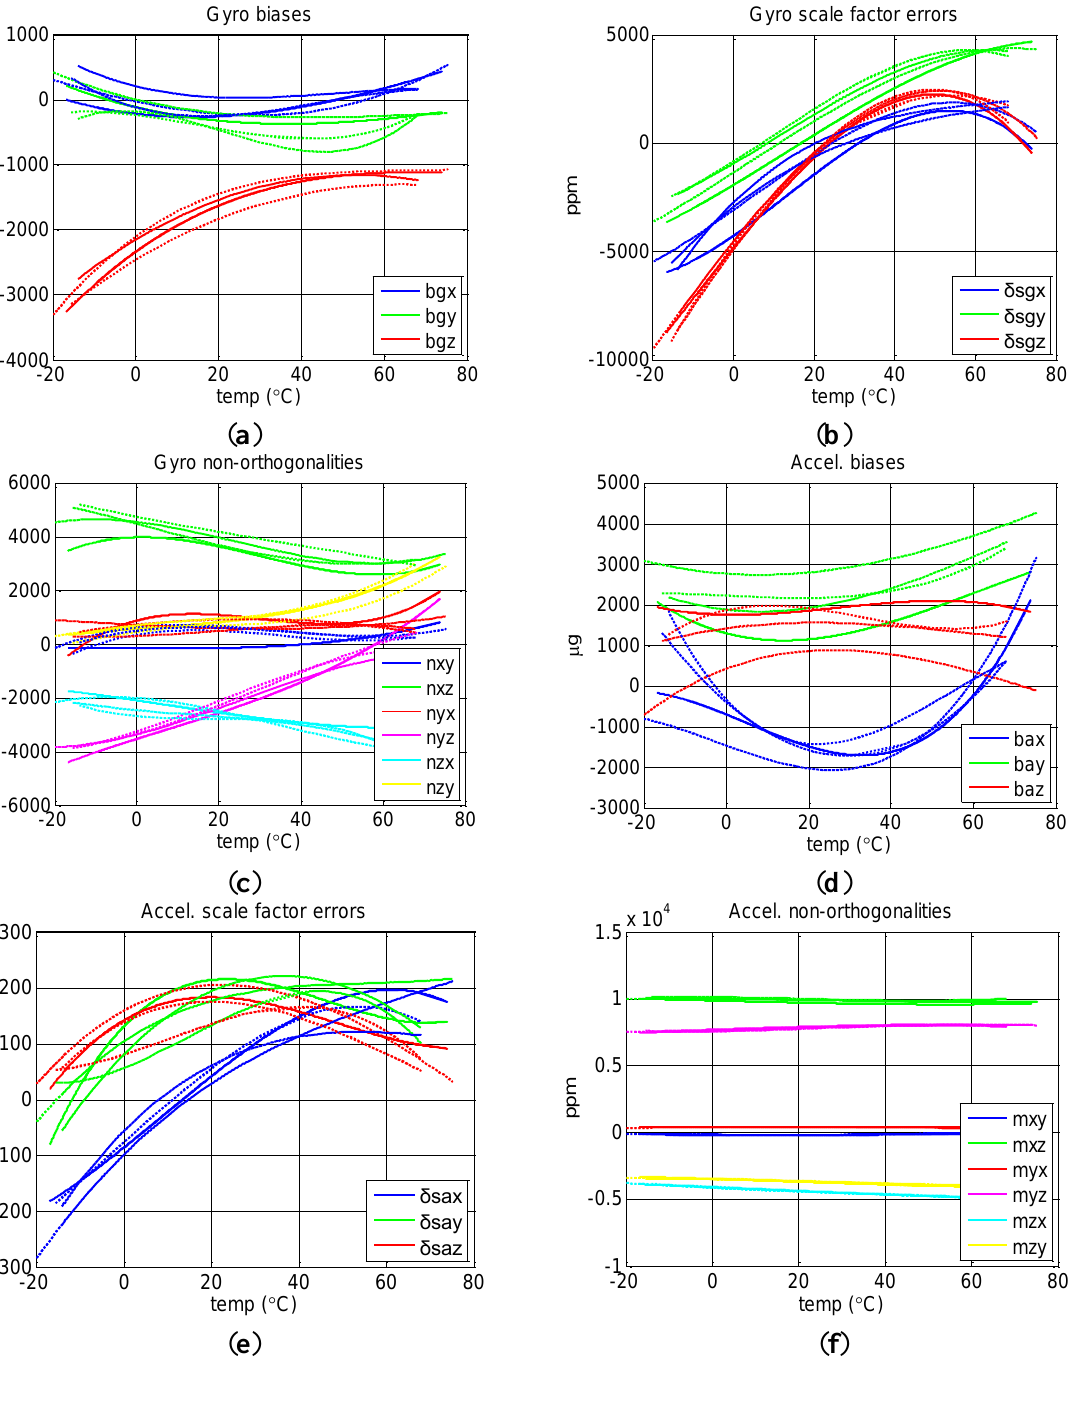
Figure 8. Thermal calibration results of MTi-G. In each subplot, three dashed lines correspond to the results of the proposed method with three different temperature profiles, and the solid line is the result of the Soak